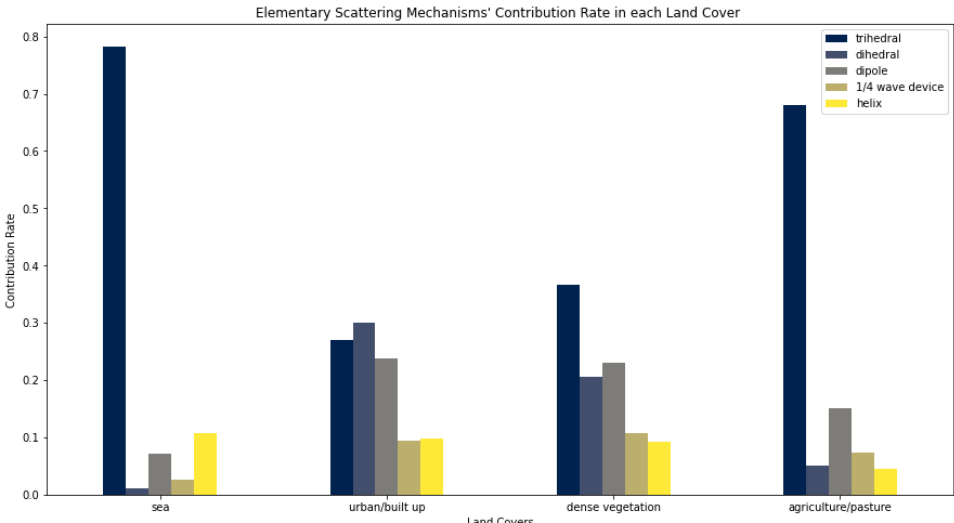
Figure 8. Mean contribution rate of fundamental scattering mechanism in each land cover. Table 4. Classification accuracies for different approaches in land cover classifications.